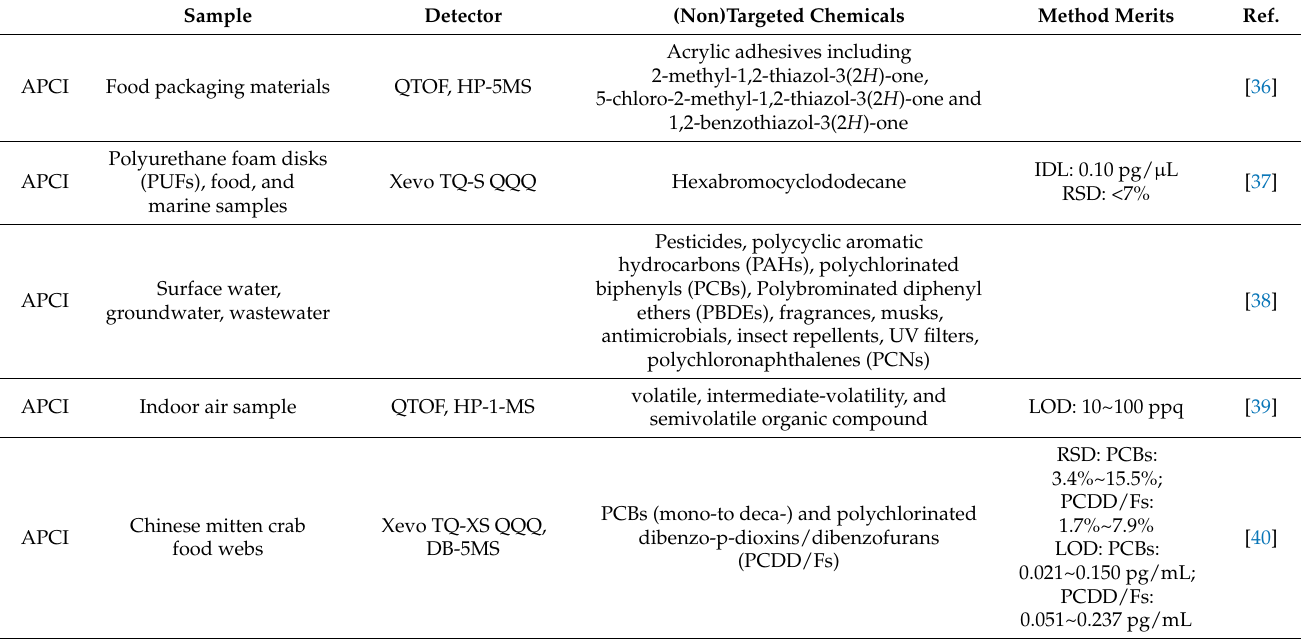
Table 1. Recent studies that employ GC–API–MS techniques for (non)targeted analysis of environmental pollutants.